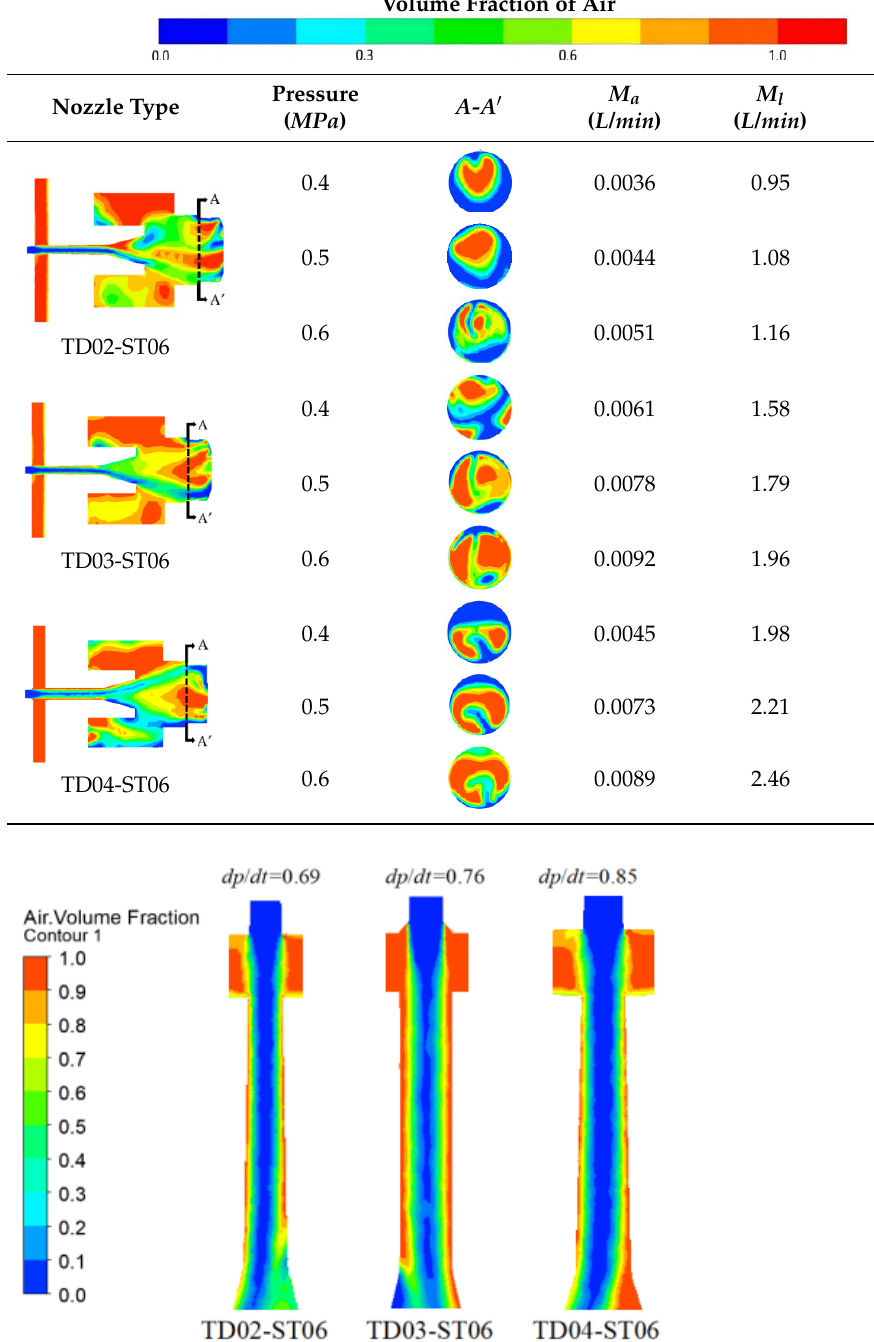
Figure 11. Droplets movement trajectory at different charging voltage.